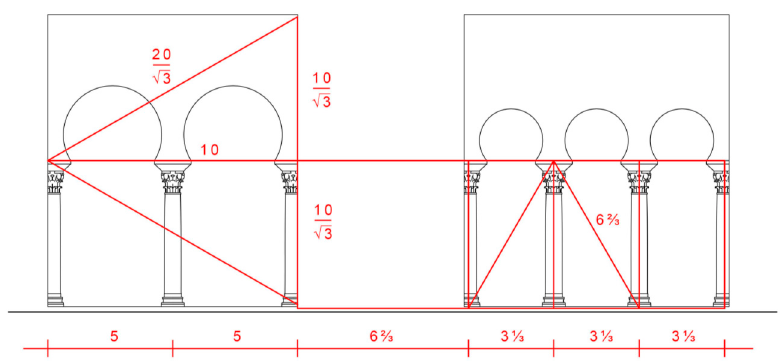
Figure 4. Design scheme of the arcades at the entrance to the hall of the D ā r al- Ǧ und at Mad ī nat al- Zahr ā ʾ , with measurements in cubits (1 cubit = 46.3 cm). Drawings by Felix Arnold.